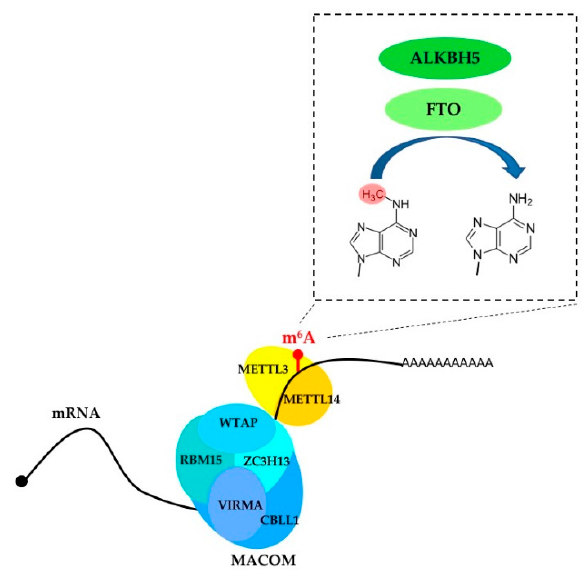
Figure 1. m 6 A modification is installed by the core METTL3/METTL14 (methyltransferase-like protein 3/methyltransferase-like protein 14) catalytic complex and erased by the two demethylases FTO (fat mass and obesity-associated) and ALKBH5 (alkB homologue 5). The MACOM complex, composed of WTAP (Wilms tumor 1-associated protein), RBM15 (RNA-binding motif 15), VIRMA (Vir-like m 6 A methyltransferase-associated), ZC3H13 (zinc finger CCCH-type containing 13) and CBLL1 (Cbl proto-oncogene like 1), guides the core complex on specific mRNAs and contributes to select specific sites within single